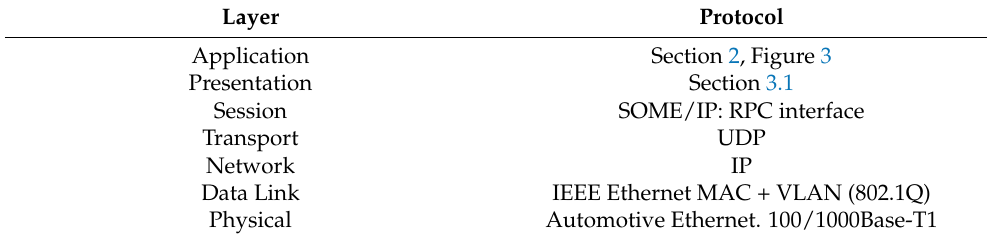
Table 8. OSI model of interconnection of the client and the server by means of SOME/IP